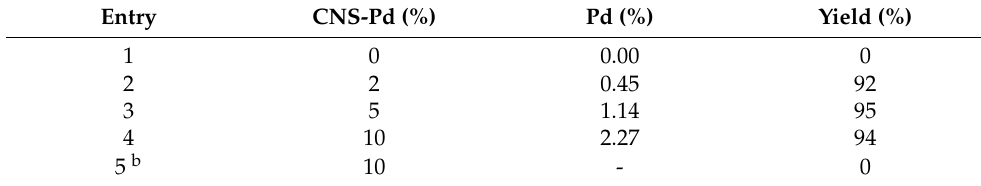
Table 2. Catalyst loading optimization a .